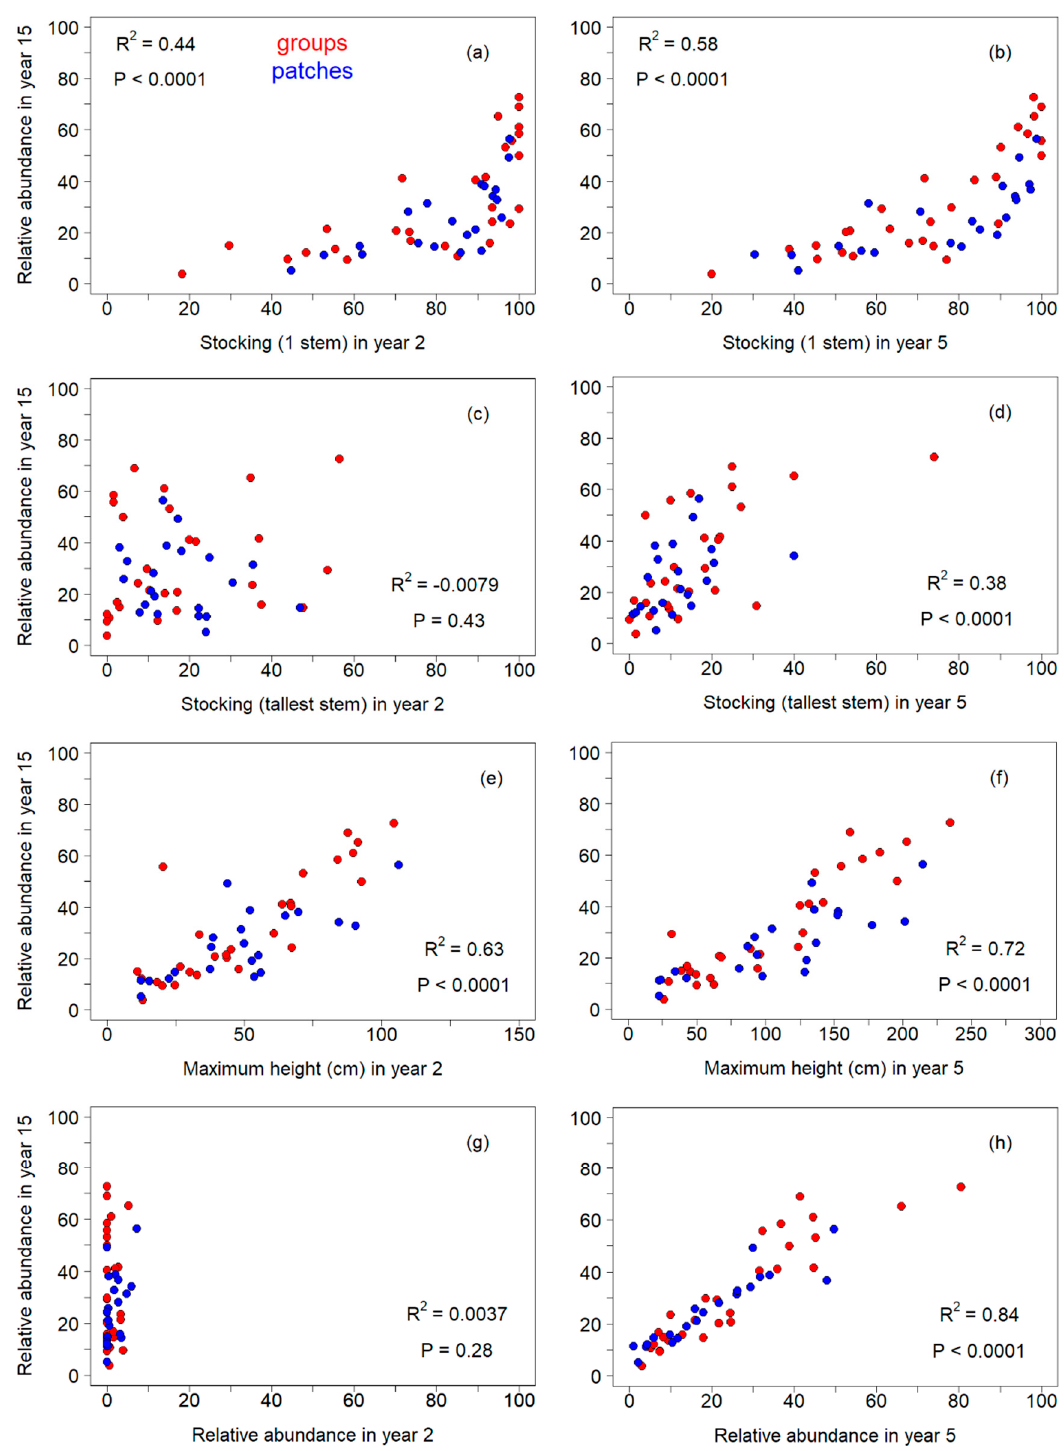
Figure 6. Relationships between relative abundance of yellow birch in year 15 and four different regeneration indices in year 2 ( a , c , e , g ) and year 5 ( b , d , f , h ), measured at the scale of 6.25-m 2 quadrats. Stockings were computed on all seedlings and saplings, while stem densities were computed on seedlings ≥ 1 m in height and saplings. Data points are cluster means. Red dots are groups, blue dots are patches. Adjusted R 2 and p -values were computed from simple linear regressions.